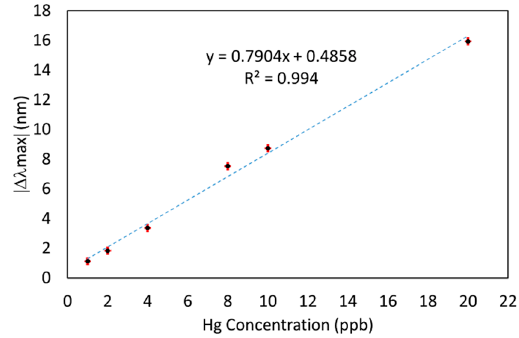
Figure 6. Maximum variation in wavelength ( ∆ λ max) for each mercury concentration (1, 2, 4, 8, 10,